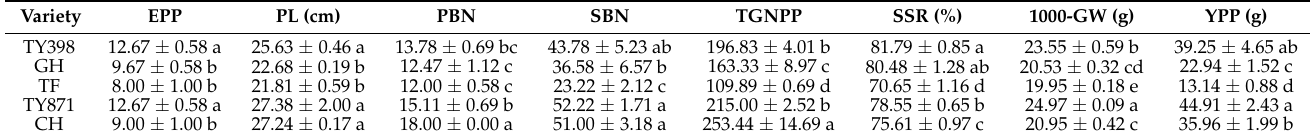
Table 1. Differences in yield and yield components of two hybrid rice varieties ( Oryza sativa L.) and their parents.